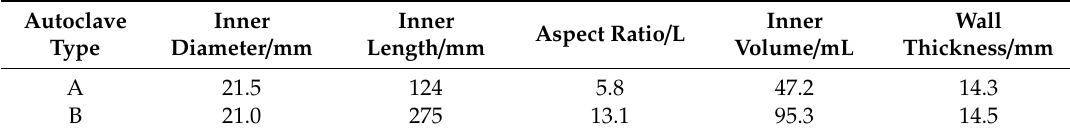
Table 1. Geometrical parameters of the autoclaves